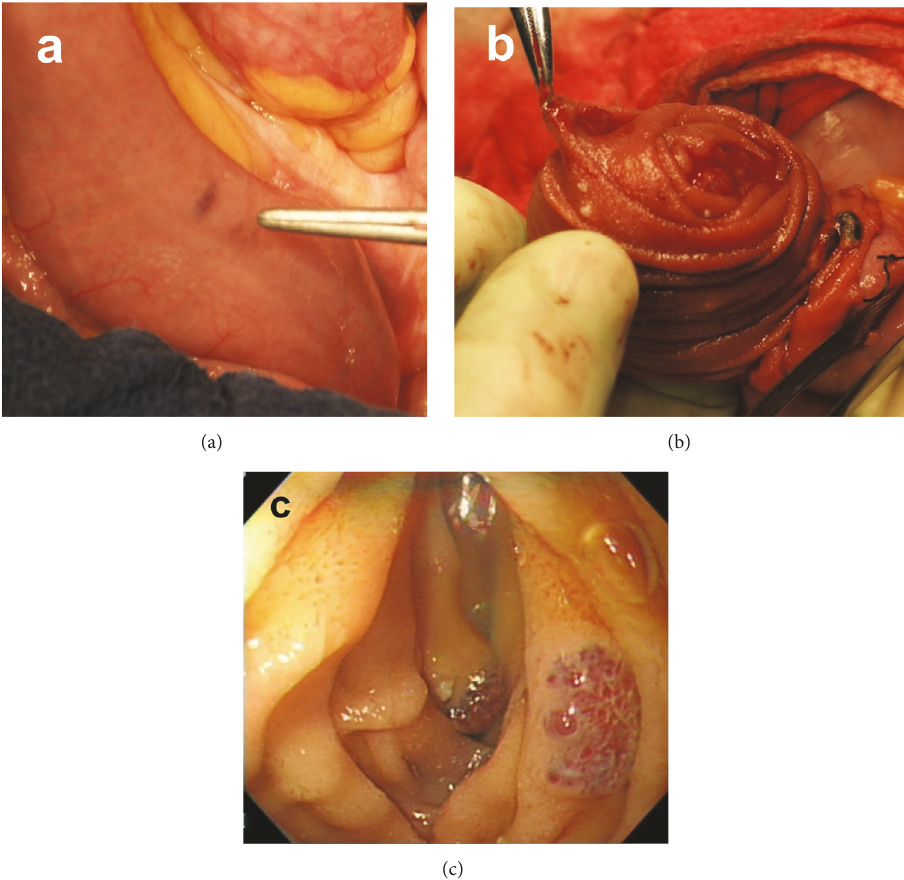
Figure 4: Demonstration of the second operation 19 years of age. (a) VM on the small intestine; (b) Lesions were exposed by intussuscepting the bowel through enterostomies; (c) Enteroscopy through the enterotomies was performed to detect the remaining